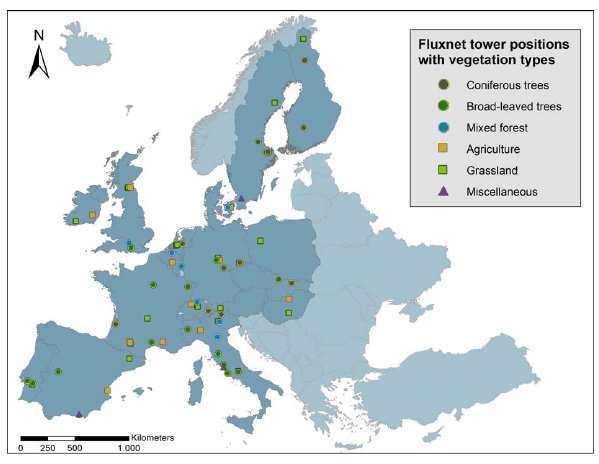
Figure 1: Distribution of 74 FLUXNET tower sites in 18 European countries. 3 Fig. 1. Distribution of 74 FLUXNET tower sites in 18 European